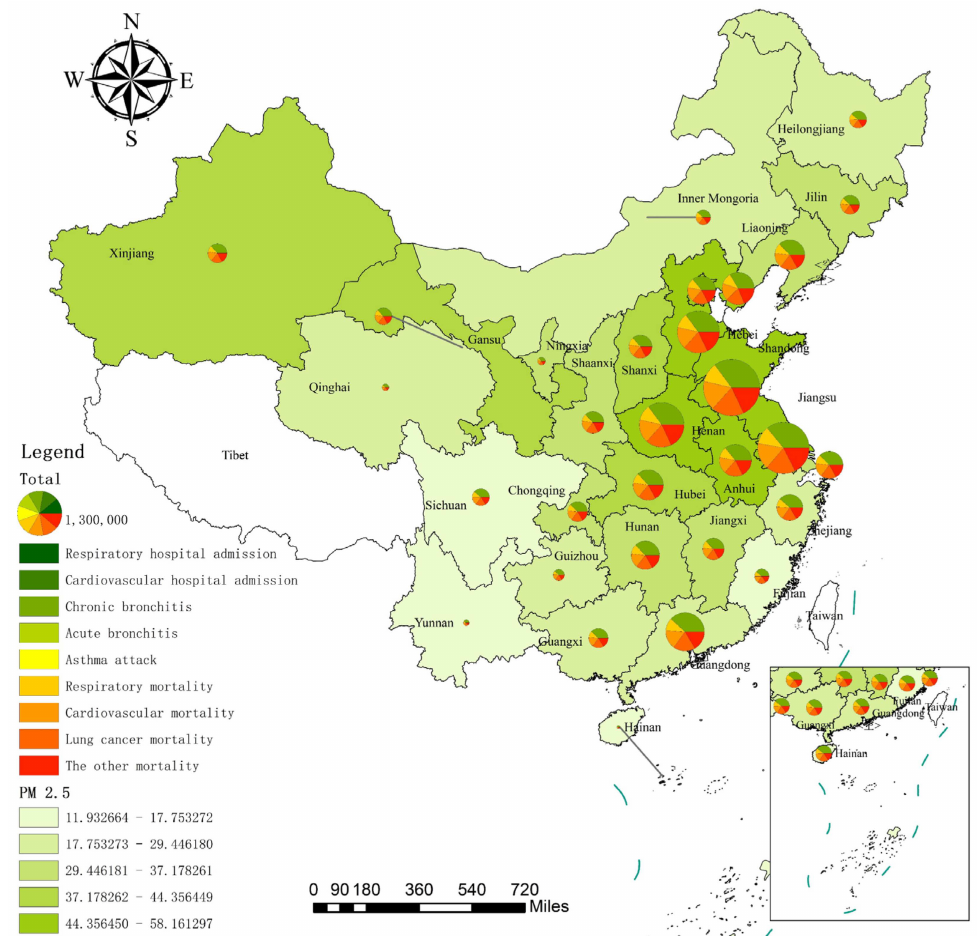
Figure 7. Spatial distribution of economic loss due to PM 2.5 exposure by province in 2017. (Notes: a. The 9 health endpoints and their respective colours are explained in the Legend. The pie chart represents the total economic loss, and the green graph at the bottom is the PM 2.5 value of each province. b. Owing to the space limitations, the spatial distribution map of other years is not shown; this can be obtained from the corresponding